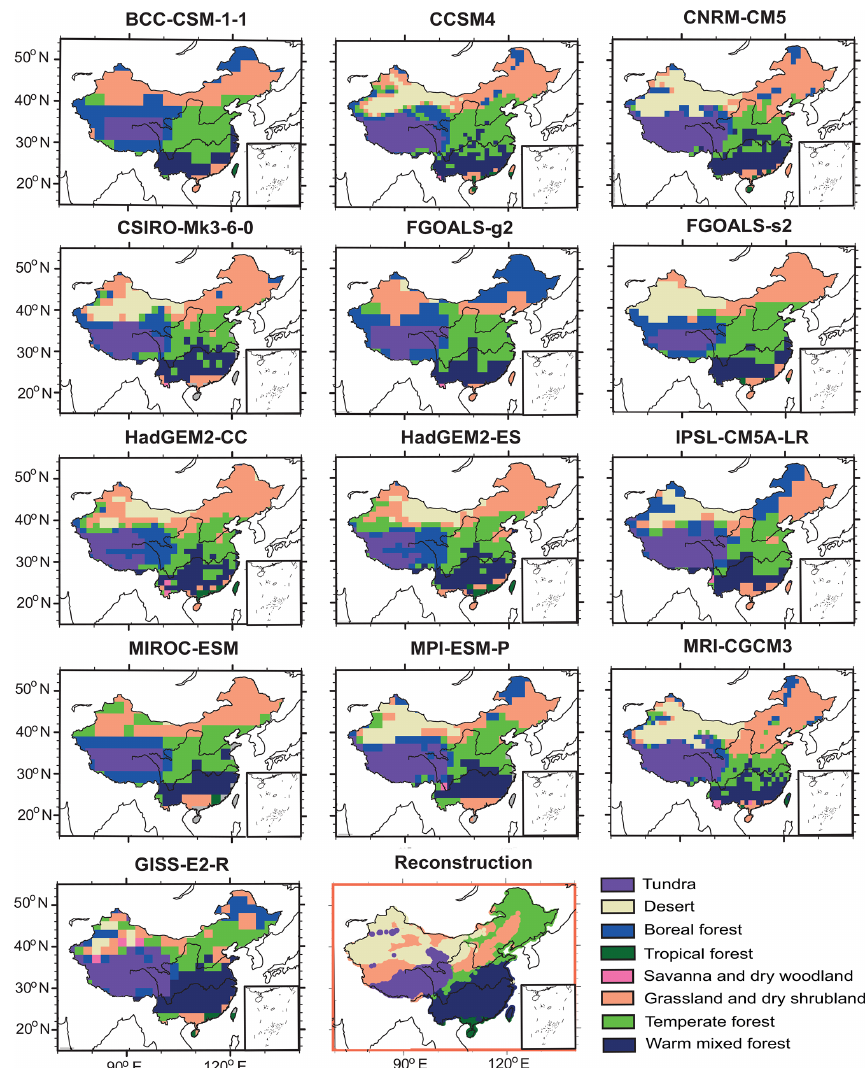
Figure 5. Comparison of interpolated megabiome distributions (plot in the red rectangle) with the simulated spatial pattern from BIOME4 for each model during the